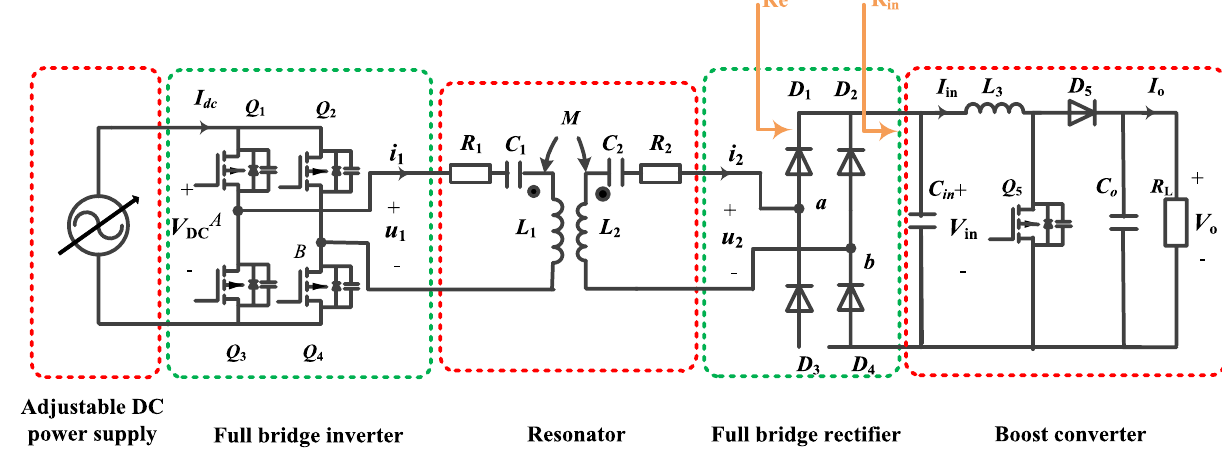
Figure 2. Simplified diagram of system structure.